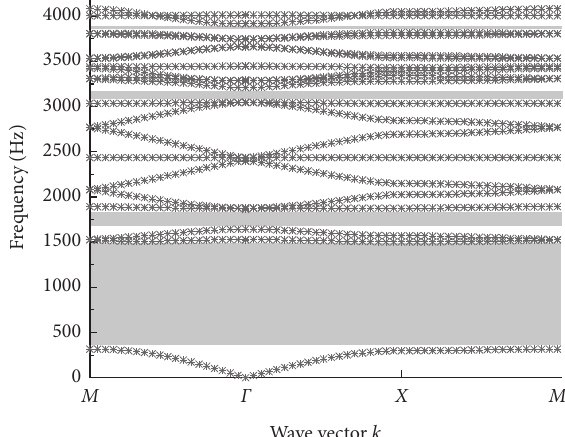
Figure 3: Band structure for ( z )-mode of damped rail with two- dimensional honeycomb